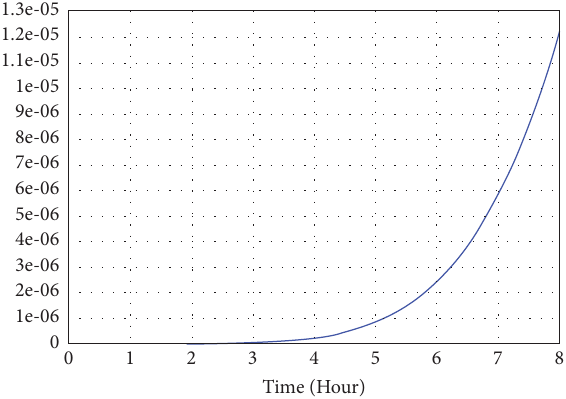
Figure 7: HEP based on equipment failure